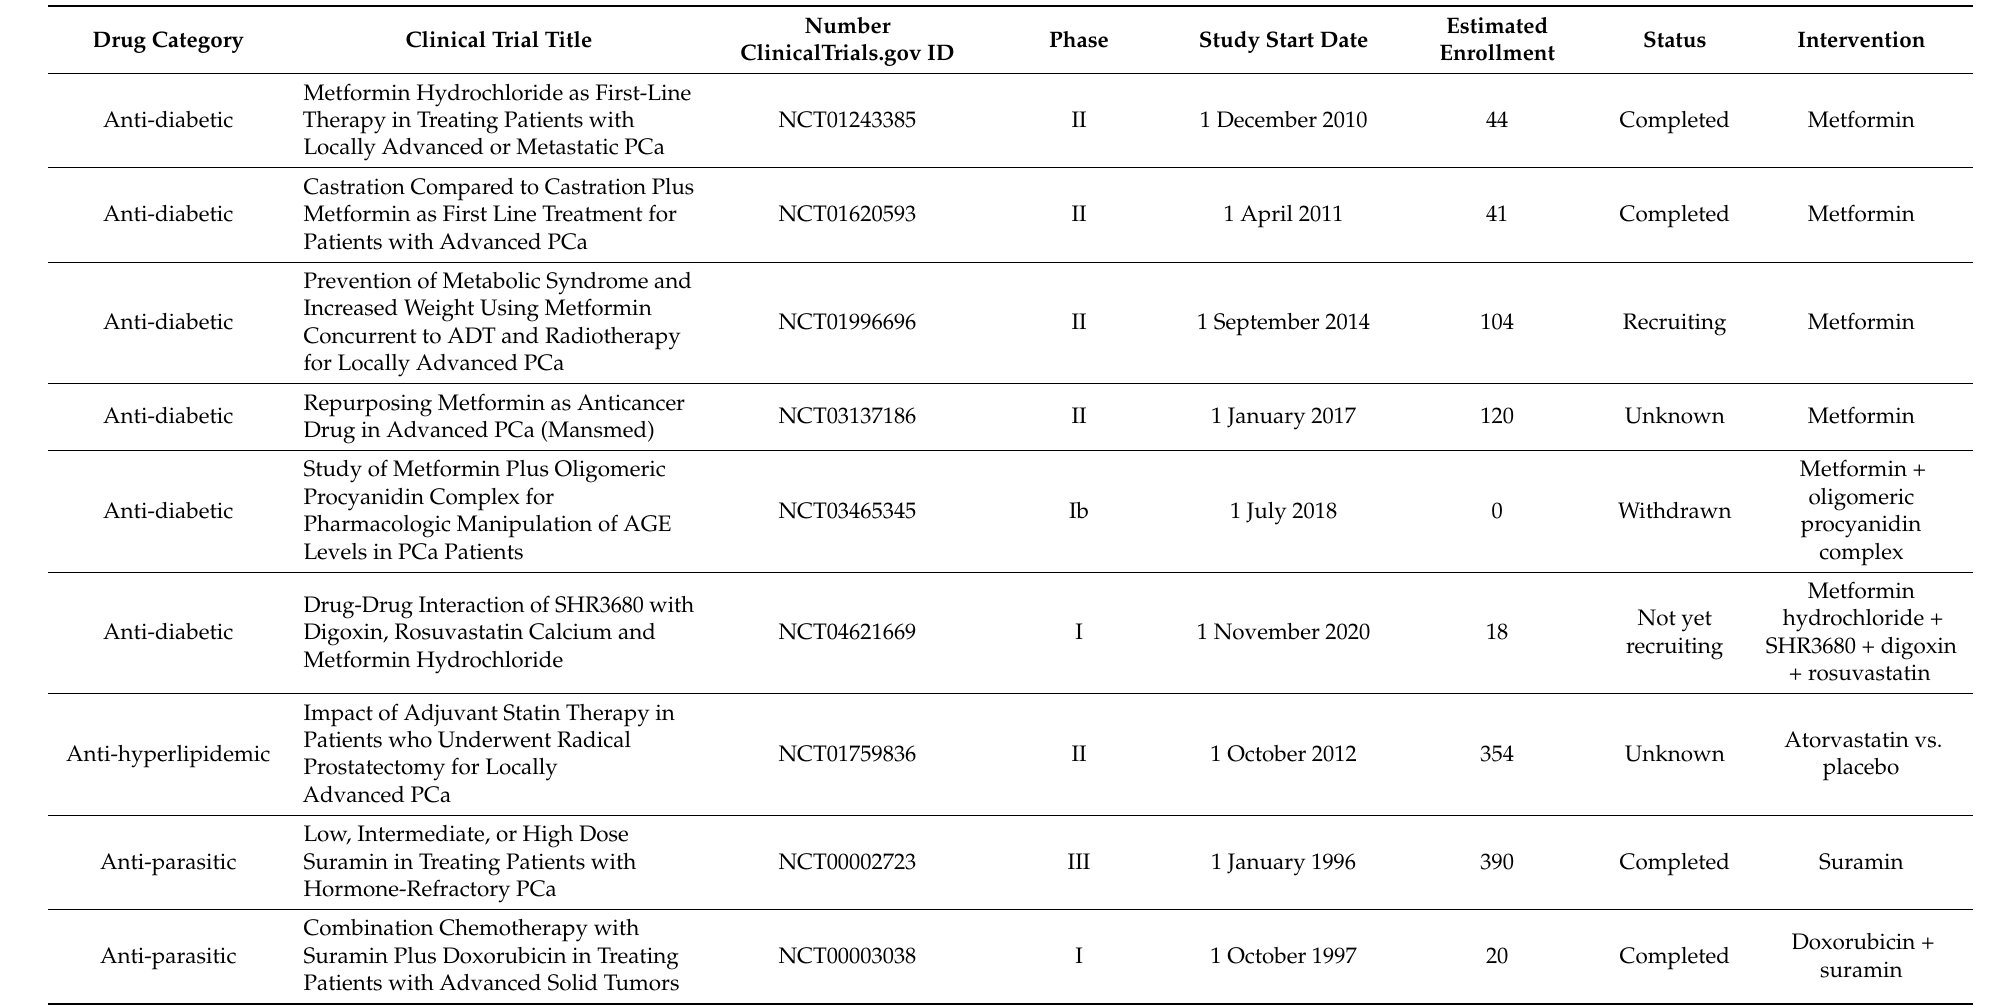
Table 2. Summary table of the drugs that have been repurposed to be used in prostate cancer in clinical